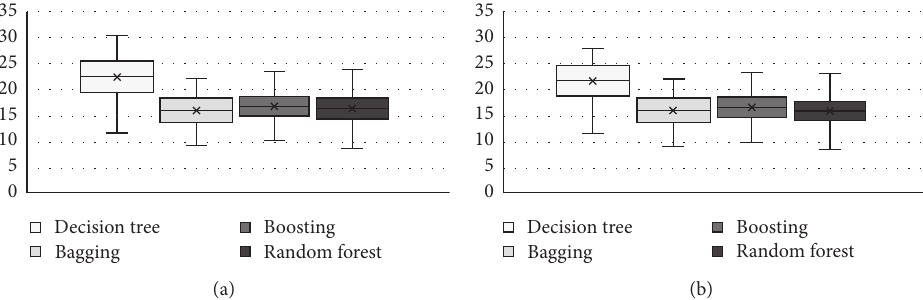
Figure 3: MAPE (a) and COD (b) main error measures of the four techniques (decision tree, bagging, boosting, and random forest) corresponding to the largest 63 municipalities in